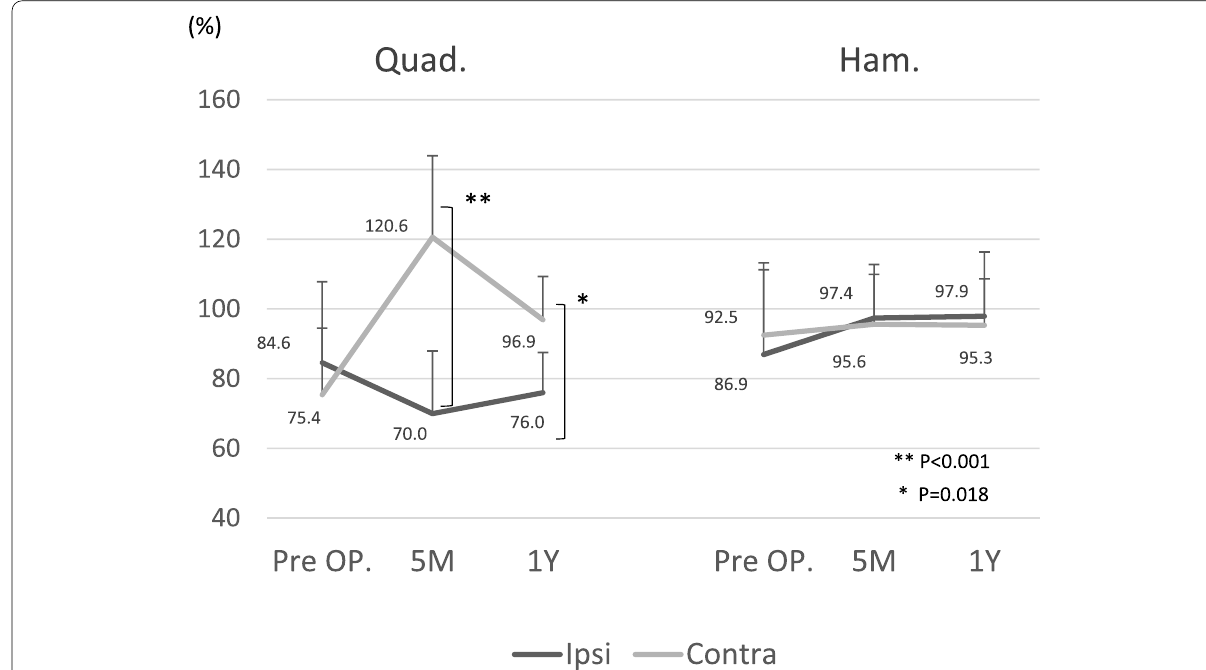
Fig. 1 When the side-to-side muscle strength ratio were evaluated, the strength of the quadriceps and hamstring muscle was not different between the two groups preoperatively (Quad.: 75.4 19% in the C-BTB vs. 84.6 21% in the I-BTB; p 0.194, Ham.: 92.5 18.7% in the C-BTB vs. ± ± = ± 86.9 17.8% in the I-BTB; p 0.49). However, quadriceps muscle strength in the C-BTB group was significantly higher than that in the I-BTB group ± = at 5 months (Quad.: 120.6 24.5% in the C-BTB vs. 70.0 12.3% in the I-BTB; p < 0.001, Ham.: 95.6 17.2% in the C-BTB vs. 97.4 23.9% in the I-BTB; ± ± ± ± p 0.055) and 12 months (Quad.: 96.9 12.4% in the C-BTB vs. 76.0 17.6% in the I-BTB; p 0.018, Ham.: 95.3 13.3% in the C-BTB vs. 97.9 12.8% = ± ± = ± ± in the I-BTB; p 0.74) =